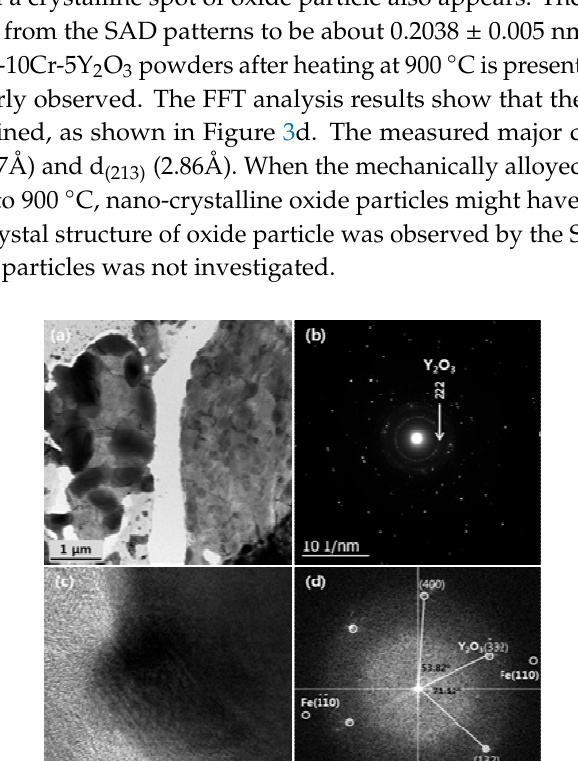
Figure 3. TEM analysis results of mechanically alloyed Fe-10Cr-5Y 2 O 3 powders after heat treatment at 90 °C: ( a ) TEM image, ( b ) SAD pattern, ( c ) HRTEM image, and ( d ) FFT pattern.